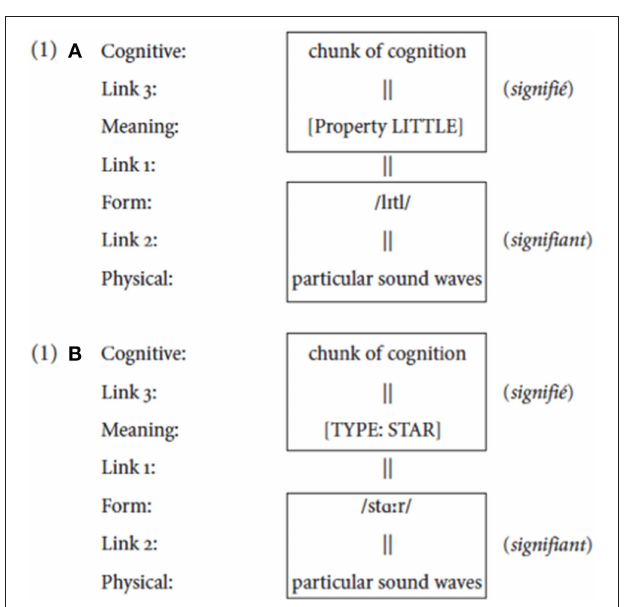
FIGURE 1 | The structure of a linguistic sign. (A) shows the structure of the word “little.” Its linguistic elements are its meaning (here simply represented as LITTLE), which is related to the combination of phonemes that are its form. These linguistic elements are each related to elements outside the realm of language: a certain chunk of cognition for the meaning LITTLE, and physical sound waves for its form. (B) shows the structure corresponding to the word “star.”